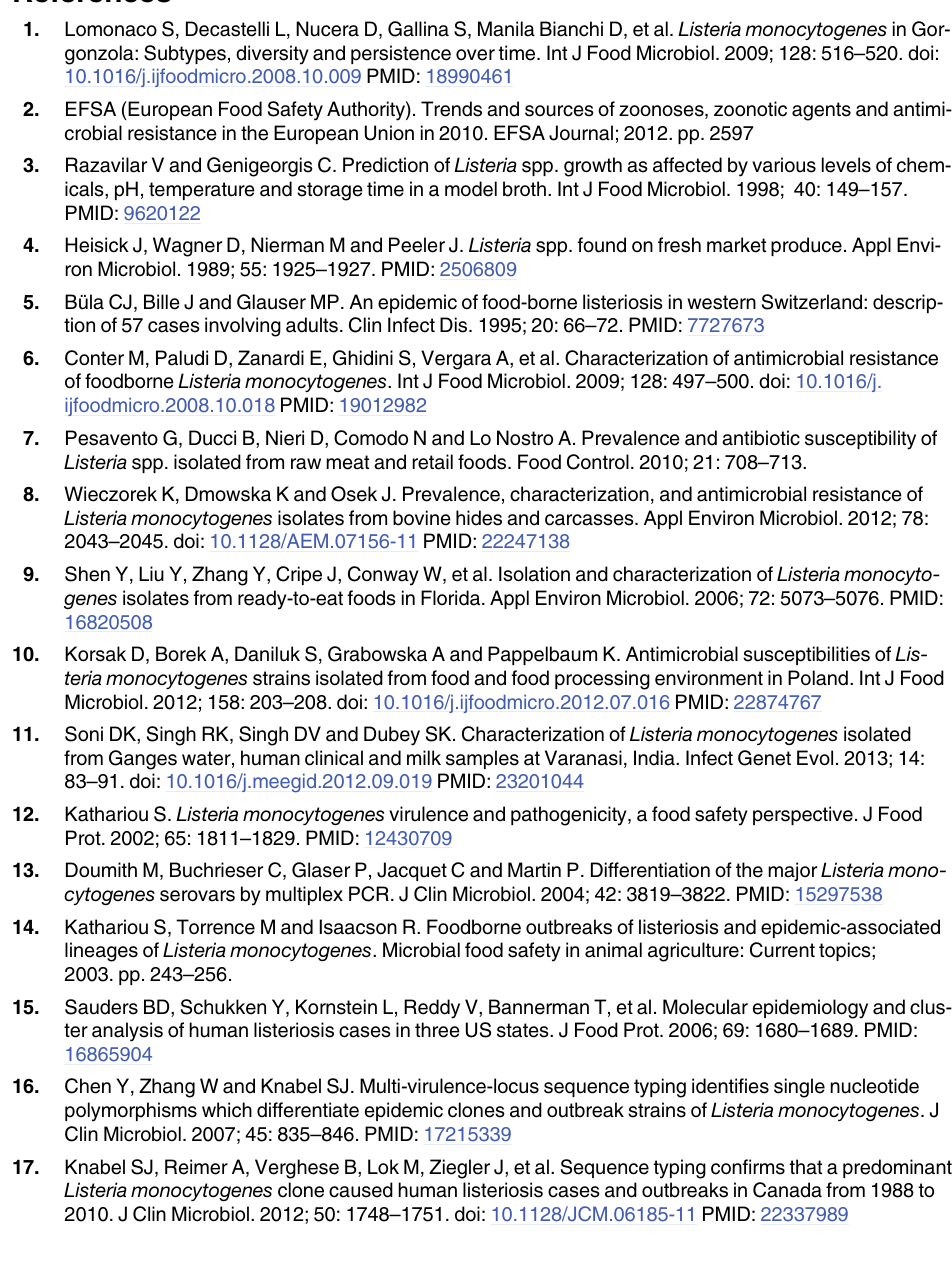
S1 Table. Information regarding the samples assessed in this